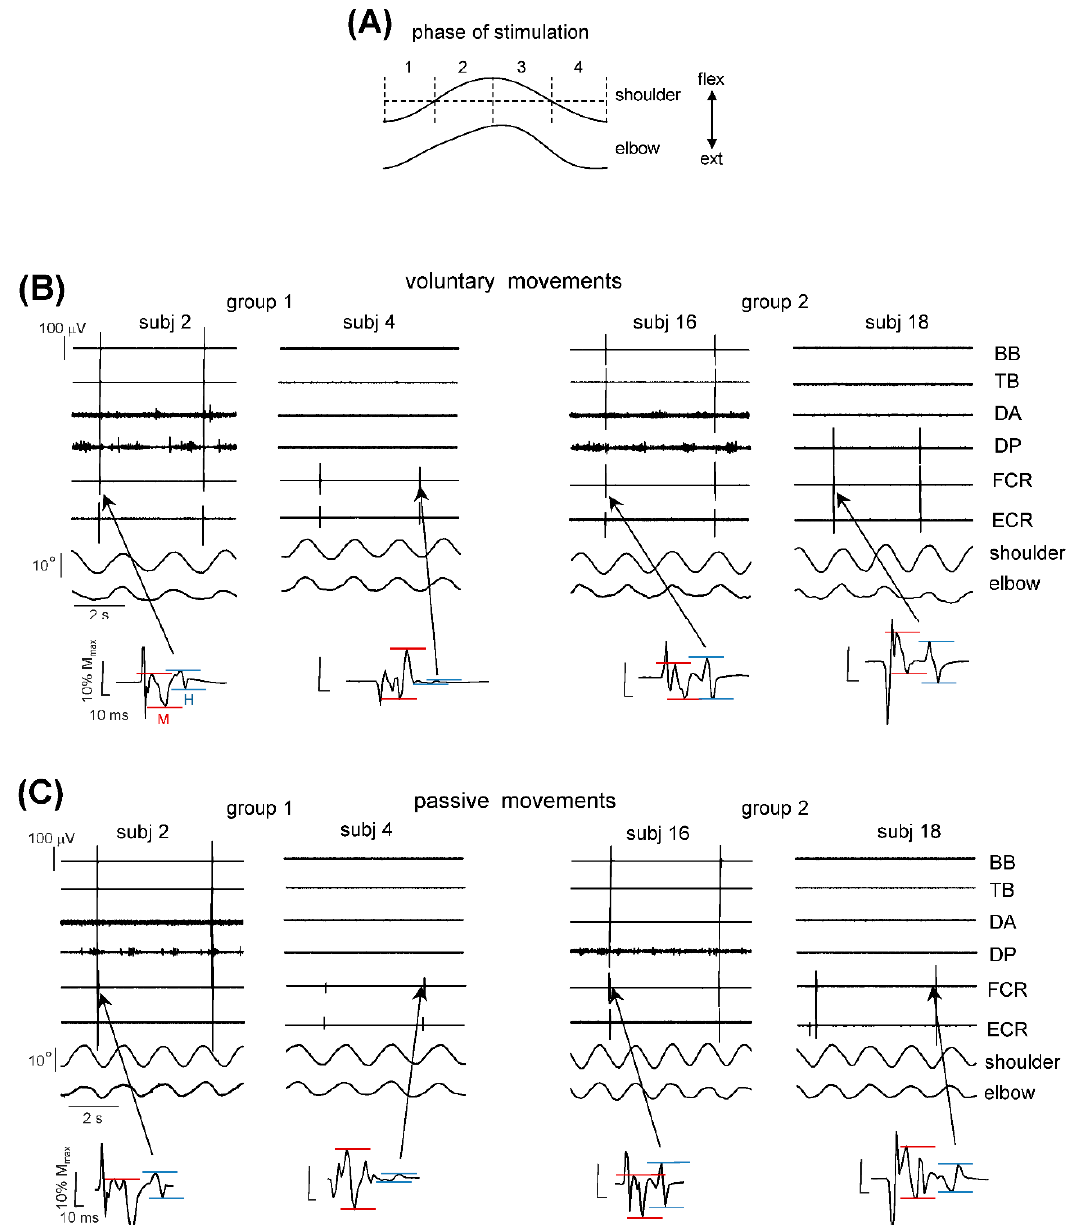
Figure 3. H-reflex measurements during rhythmic movements. ( A )—phases (1–4) of stimulation (the onset of the cycle was defined as the maximum shoulder extension). ( B )—examples of the H- reflex measurements during voluntary rhythmic movements in the subjects from group 1 (subj.